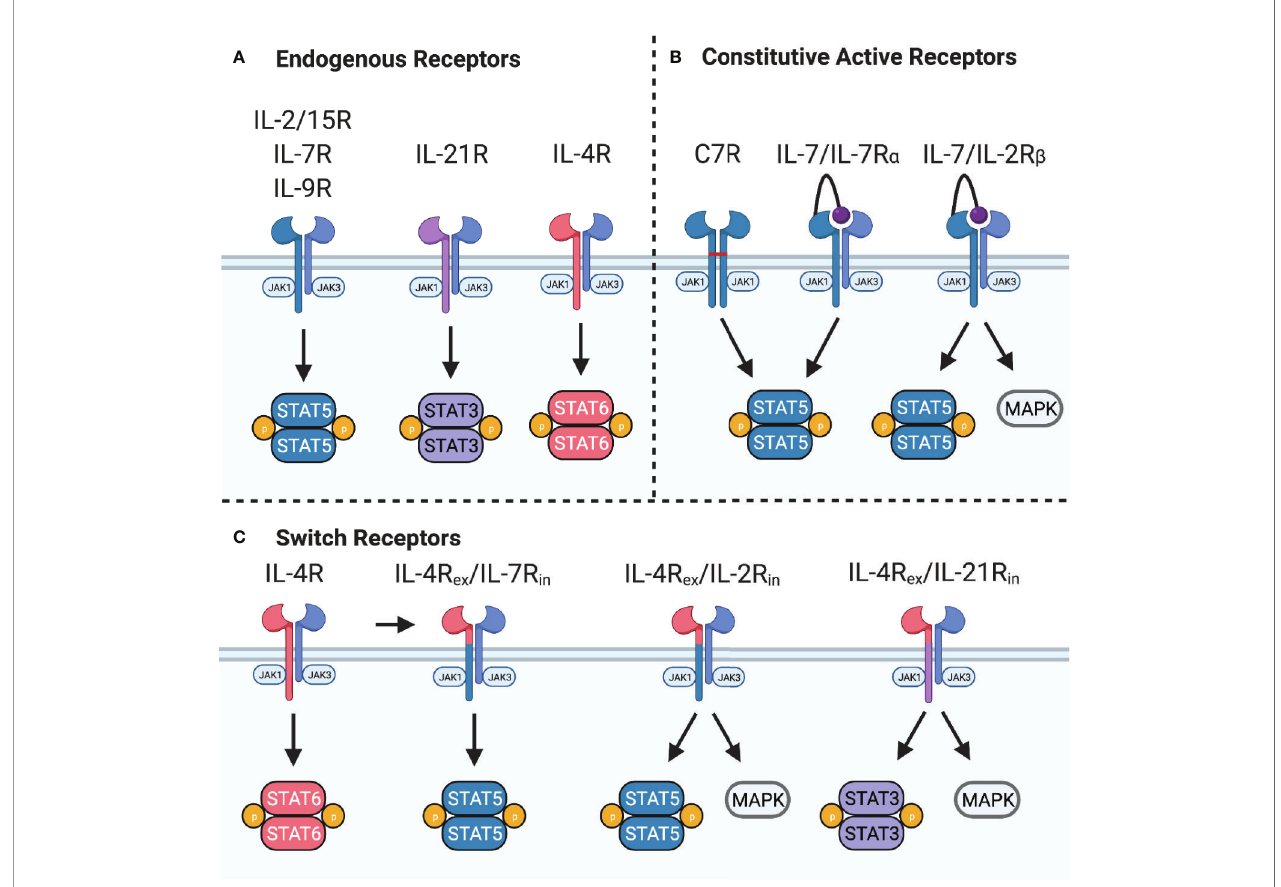
FIGURE 3 | Common gamma chain cytokine signaling and synthetic receptors. (A) Common gamma chain cytokine receptors IL-2/15R, IL-7R, and IL-9R signal primarily through STAT5 while IL-21R signals primarily through STAT3. IL-4R signals through STAT6 to induce Th2 polarization. These receptors also activate PI3K and all except IL-7R activate MAPK pathways. (B) Constitutive active variants of IL-7R can provide constant STAT5 activation. C7R is formed from homodimerization of IL-7R a chain mutants through a disul fi de bridge in the transmembrane domain. A constitutively active IL-7R provides constant STAT5 and PI3K signaling by expression of IL-7 tethered to IL-7R a . Switching the IL-7R a intracellular domain with IL-2R b provides constant STAT5, PI3K, and MAPK signaling. (C) Switch receptors bind an immunosuppressive cytokine, such as IL-4, and convert it into a stimulatory signal. These receptors are composed of the IL-4R a extracellular domain (IL-4R ex ) fused to the IL-7R a , IL-2R b , or IL-21R intracellular domain (IL-7R in , IL-2R in , or IL-21R in